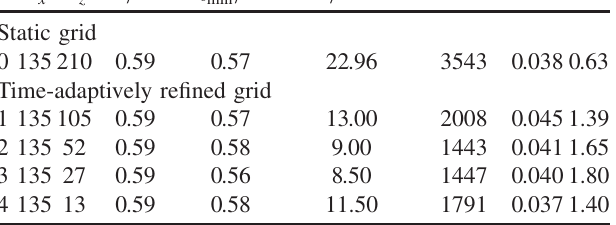
TABLE III. Results of LT-FIT simulations: The top data row lists results obtained on a static, equidistant grid. Below, results obtained on time-adaptive grids using slope-limited Akima splines are displayed.